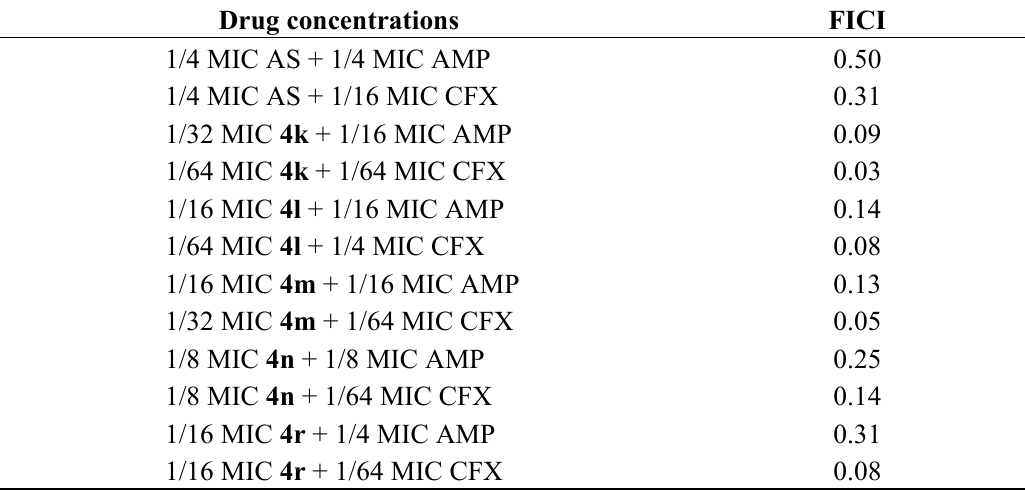
Table 2. FICI values for DHA derivatives in combinations with ampicillin and cefuroxime against E. coli AG100A/pET28a-AcrB. Synergistic effects of different concentrations of DHA derivatives in combination with ampicillin and cefuroxime were evaluated using chequerboard method. FICI values were interpreted as follows: <0.5 = synergy; 0.5–4.0 = no interaction; and >4.0 = antagonism. AMP, ampicillin; CFX,